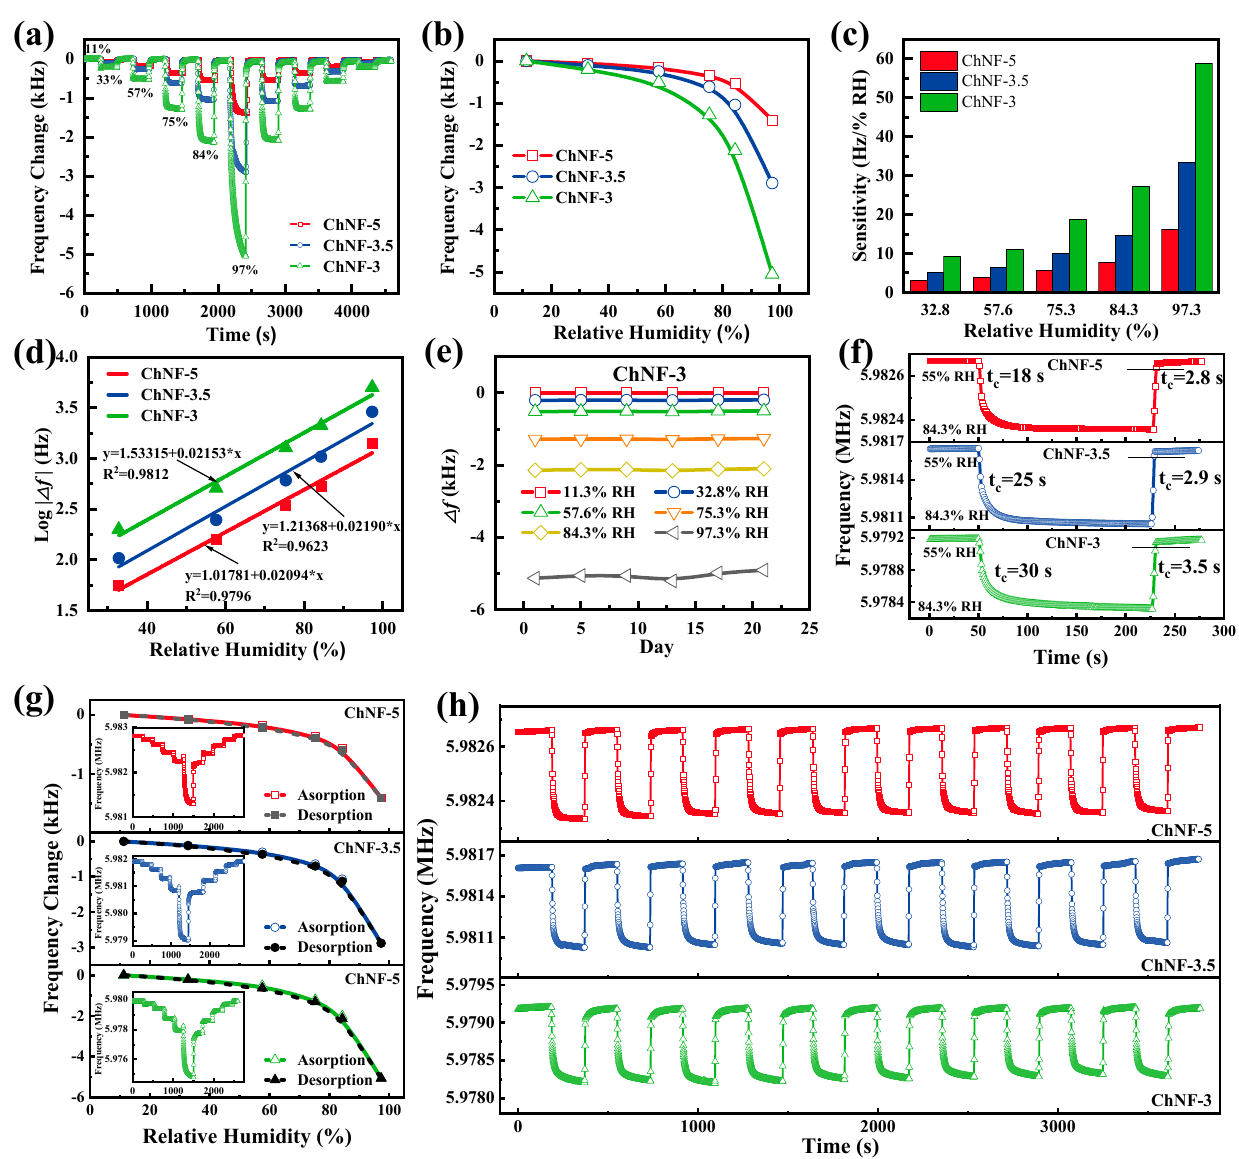
Figure 5. The humidity-sensing properties of ChNF-integrated QCM sensors: ( a ) dynamic response, ( b ) static frequency response ( c ) sensitivity variation, ( d ) fitted curve of log| ∆ f| vs. RH, ( e ) long-term stability, ( f ) humidity hysteresis, ( g ) response/recovery times, and ( h ) repeatability. The sensitivity for frequency-response humidity sensors is usually defined as the ra- imum frequency changes of ChNF-5, ChNF-3.5, and ChNF-3 at 97.3% RH were 1400, 2880,